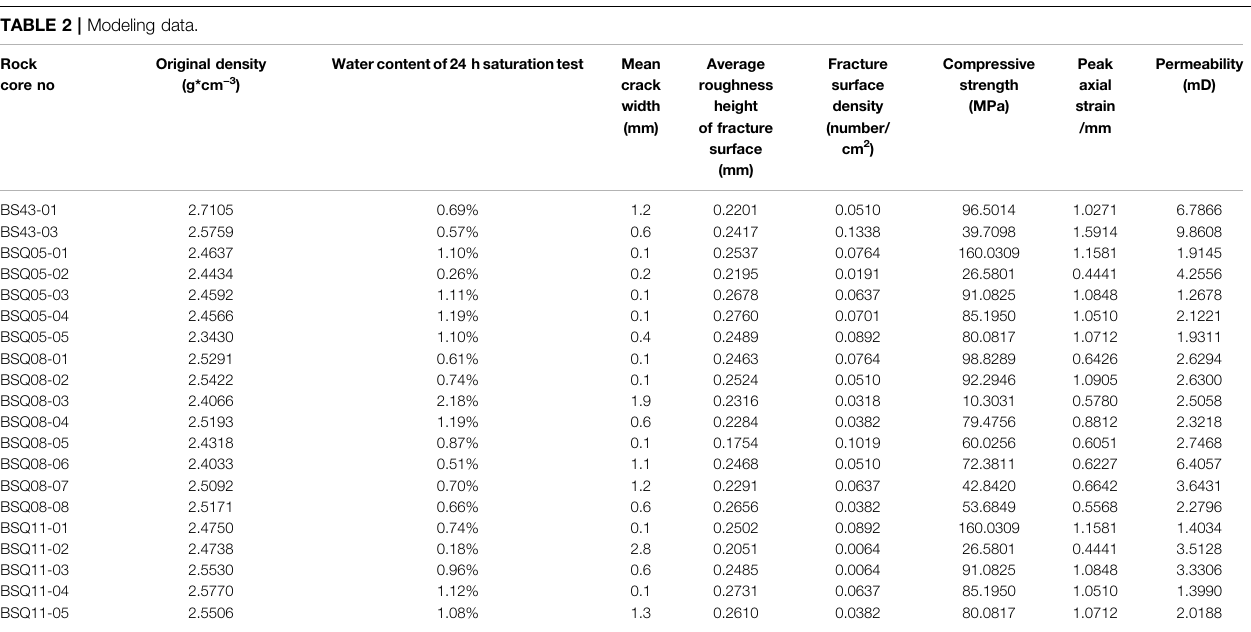
TABLE 2 | Modeling